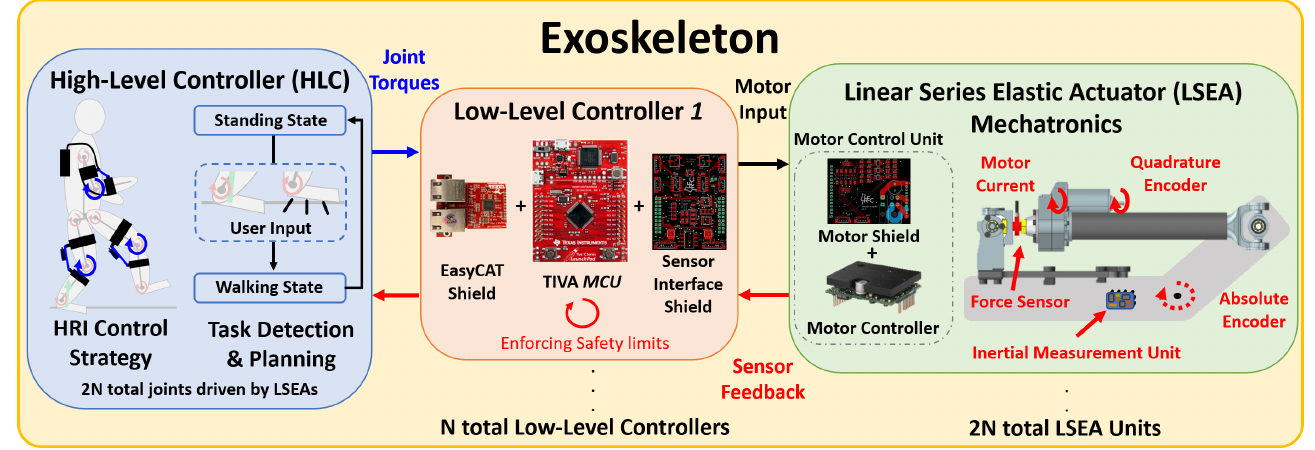
Figure 1. This represents the abstract exoskeleton design robotic system that we are designing the low-level controller